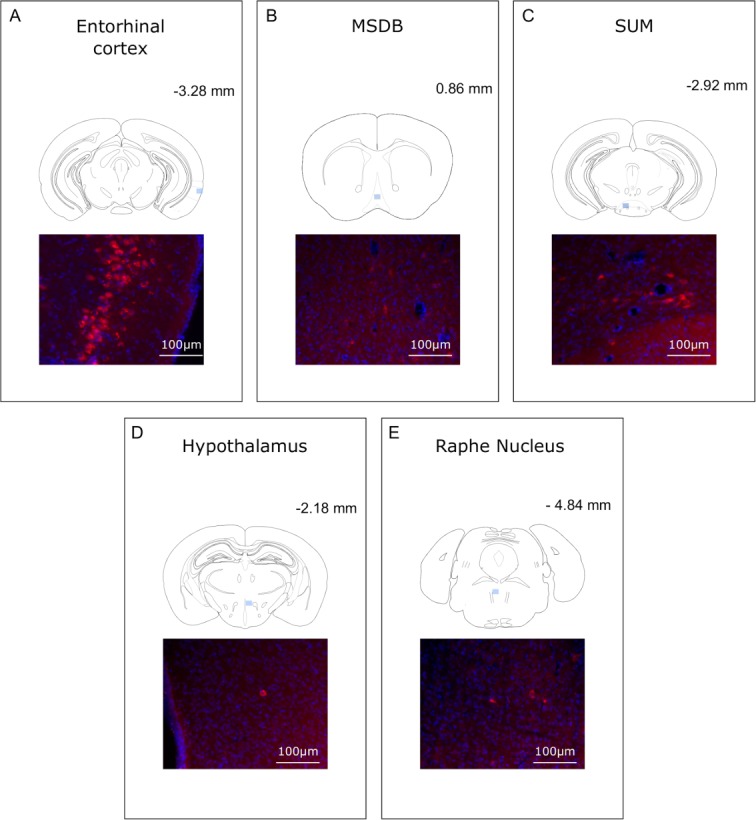
Analysis of CTB retrograde labeling indicates that rabies labeled structures at 30 hr post-infection are potential first relay regions.(A-E) Localization and representative photomicrographs of CTB-positive cells (red) in the entorhinal cortex, MSDB, SUM, hypothalamus and Raphe Nucleus, confirming that these regions are putative first relays to the hippocampus. Coronal sections are counterstained with DAPI (blue). The localization of the CTB staining is indicated by a blue insert on a standard coronal outline of a brain section, and rostro-caudal position according to Bregma is indicated in the top-right corner. Abbreviations; MSDB, medial septum/diagonal band of Broca; SUM, supramammillary nucleus.